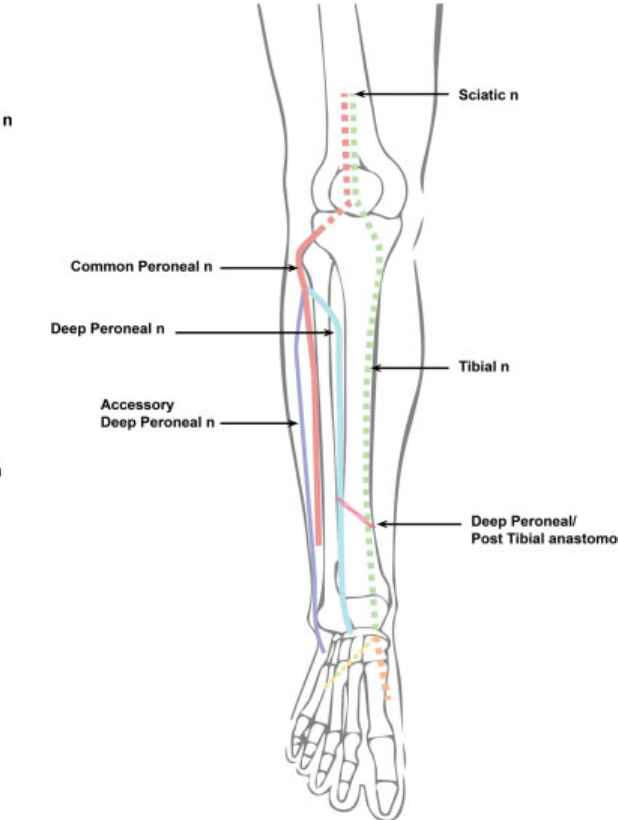
Fig. 3 Illustration of deep peroneal/post tibial anastomosis that must be present to obtain our results. It is shown as red slanted